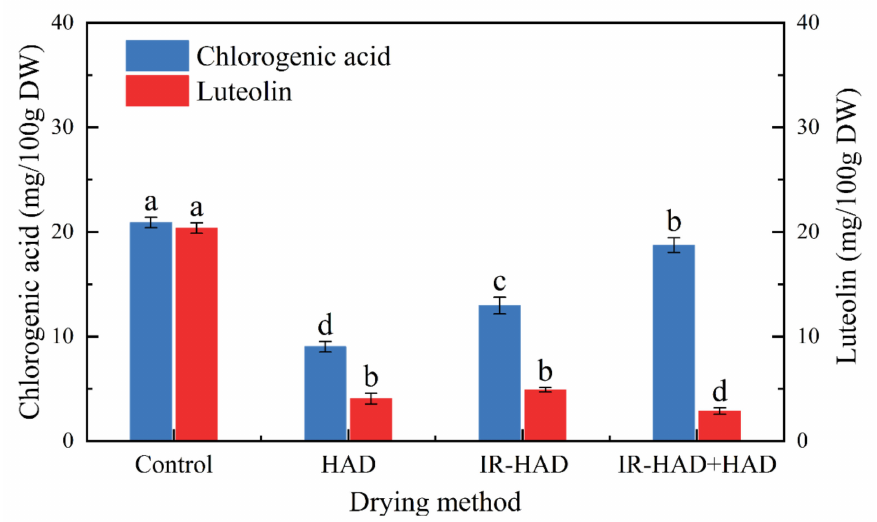
Figure 9. The contents of chlorogenic acid and luteolin in chrysanthemum cakes dried by different methods. Control: freeze-drying; HAD: hot air drying at 65 ◦ C; IR-HAD: combined infrared and hot air drying at 65 ◦ C; IR-HAD + HAD: sequential IR-HAD and HAD at 65 ◦ C. Different lower- case letters (a–d) represent significant differences between the values of different drying methods ( p <